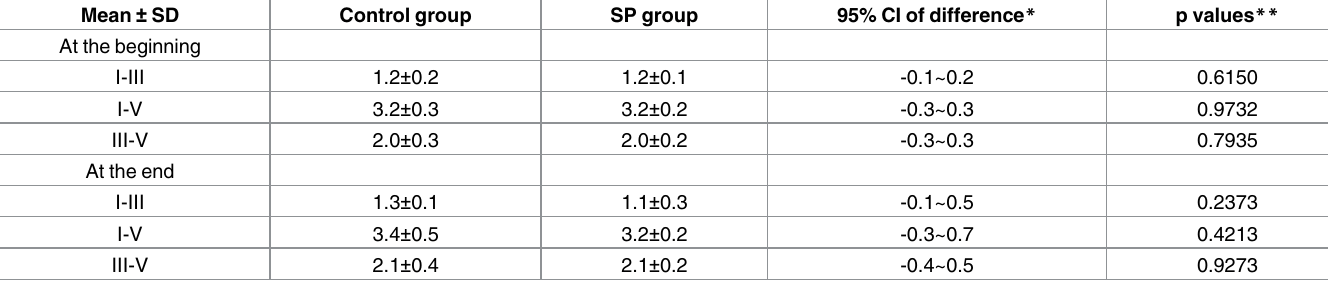
Table 2. ABR intervals by click sound of the both groups at the beginning and the end of this study. Mean ± SD Control group SP group 95% CI of difference * p values ** At the beginning